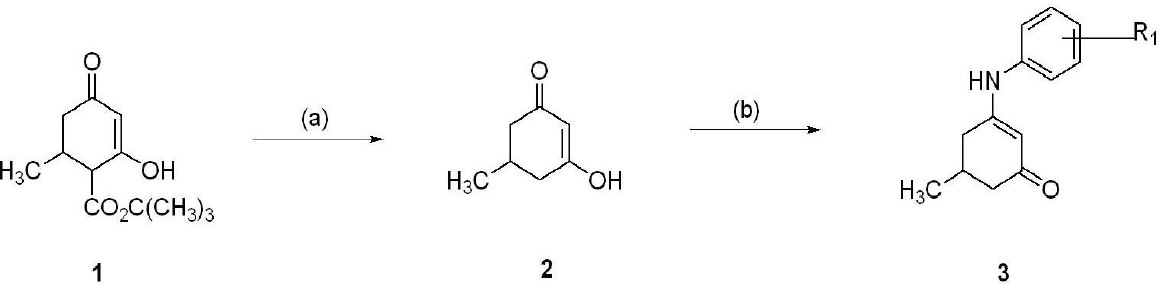
Figure 4. Synthesis of aniline enaminones. From [18].